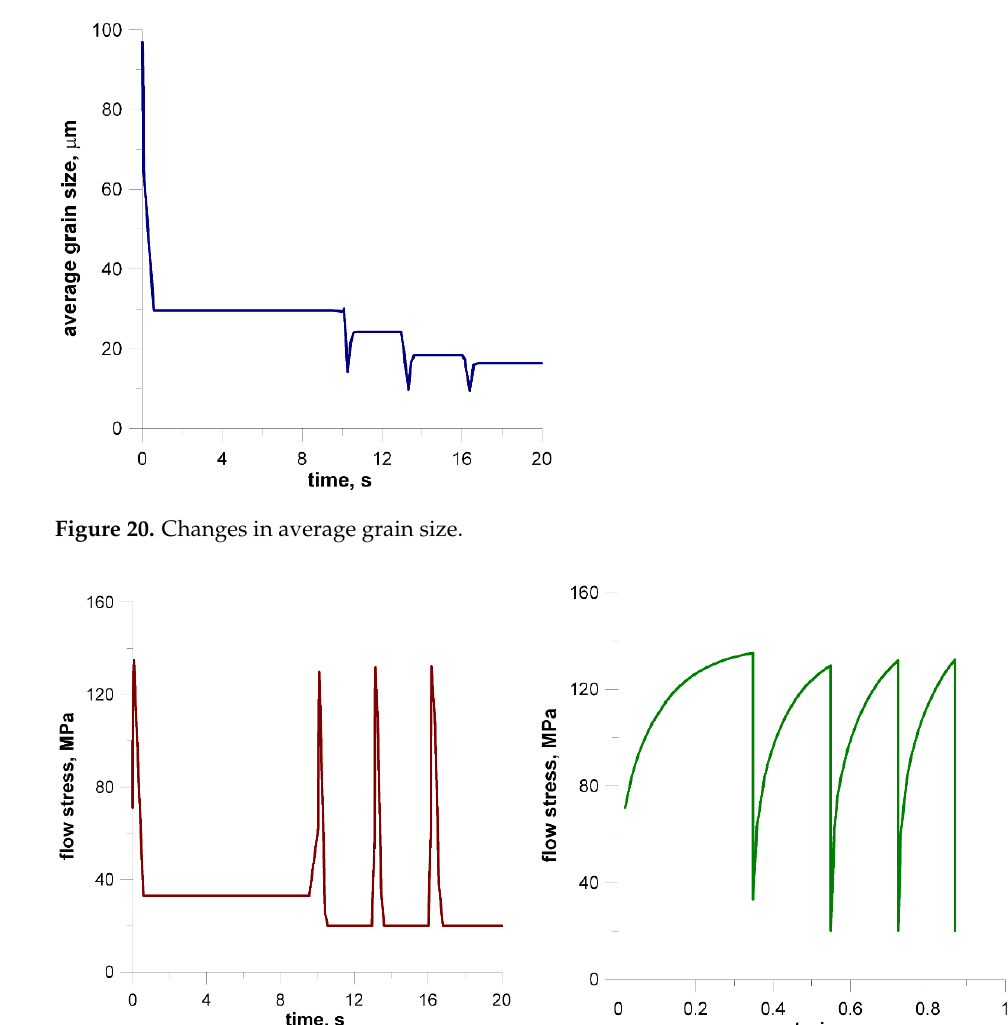
Figure 19. Microstructures: ( a ) initial, ( b ) before 2nd pass, ( c ) before 3rd pass, ( d ) before 3rd pass and after the modeled space reduction—Cut X, ( e ) before the 3rd pass and after the modeled space reduction—Cut Y, ( f ) before the 4th pass, ( g ) before the 4th pass and after the modeled space reduction—Cut X, ( h ) after the 4th pass and cooling.